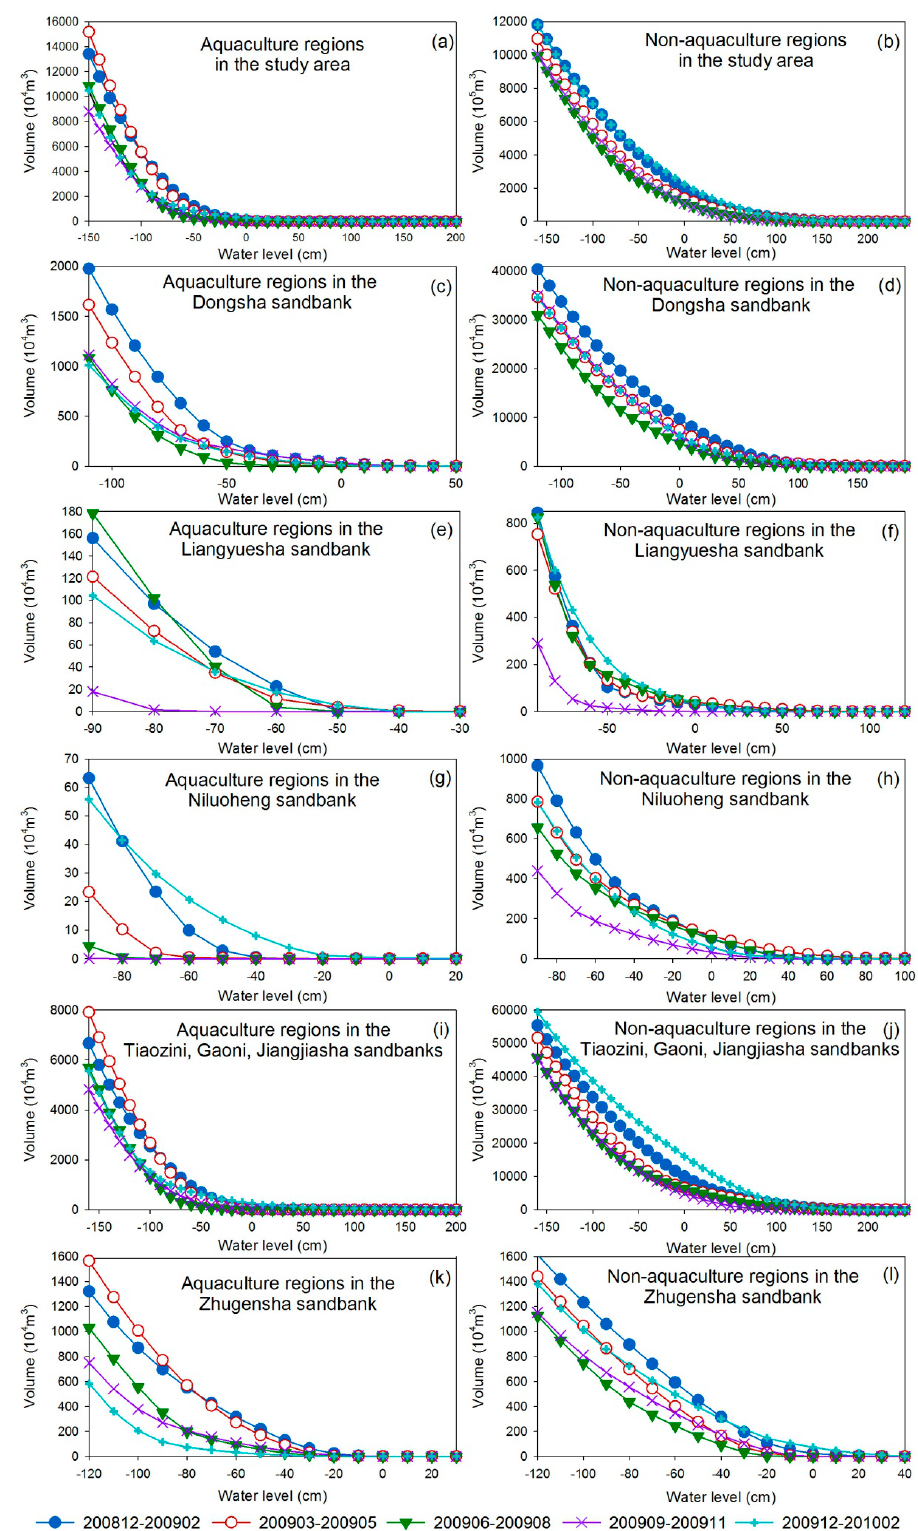
Figure 5. Seasonal patterns of tidal flats in aquaculture and non-aquaculture regions of the central Jiangsu coast. ( a ), ( b ) The entire study area; ( c ), ( d ) the Dongsha sandbank; ( e ), ( f ) the Liangyuesha sandbank; ( g ), ( h ) the Niluoheng sandbank; ( i ), ( j ) the Tiaozini, Gaoni and Jiangjiasha sandbanks; and ( k ), ( l ) the Zhugensha sandbank. The datum of the water levels is the mean sea level.